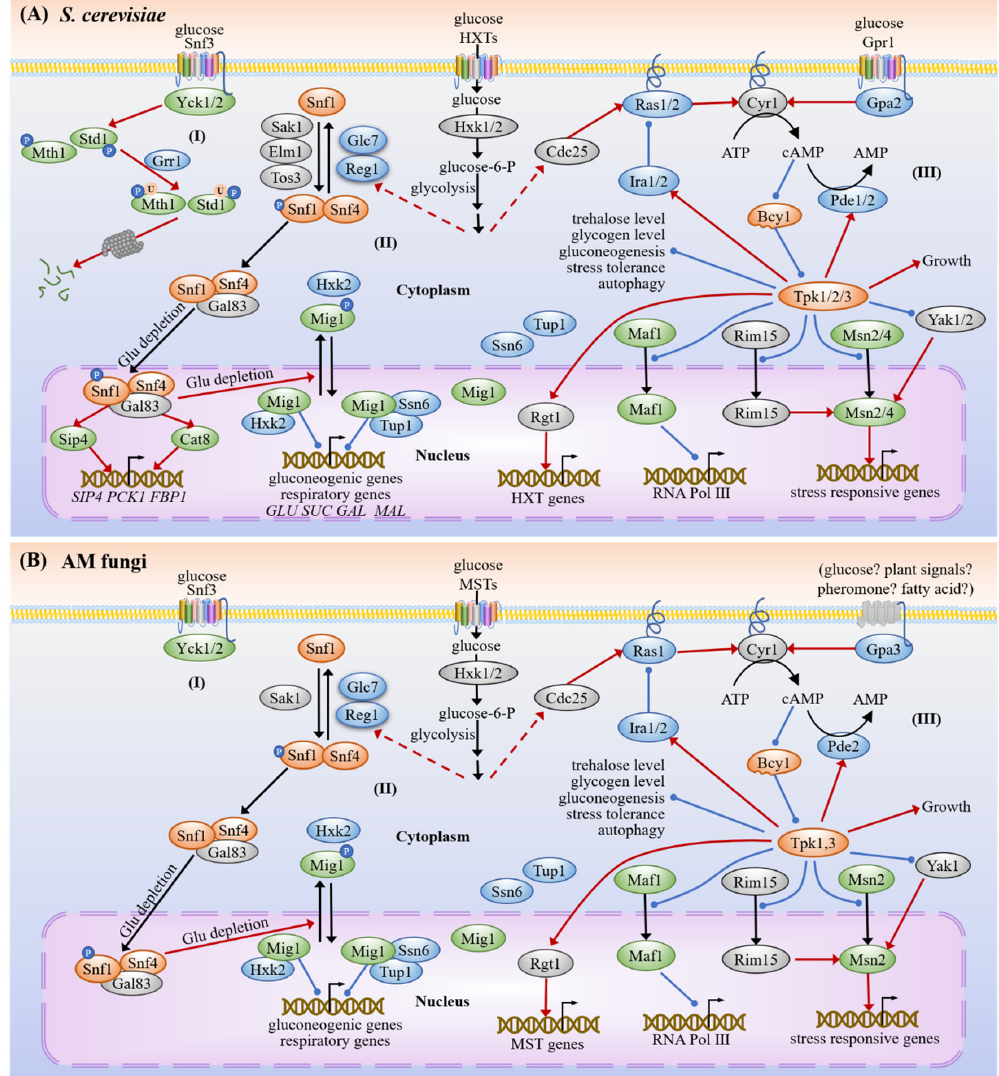
Figure 2. Carbon sensing and signaling pathways in yeast ( A ) and AM fungi ( B ). In the presence of glucose, Snf3/Rgt2 and Tpk3-dependent protein kinase trigger the induction of hexose transporter genes expression via Rgt1. The hexose transporters transport glucose into the fungal cell. Then, the Hxk1 and Hxk2 promote an increase in the intracellular glucose content. During glucose starvation, the activated Snf1 interacts with Snf4 and one of β -subunits Gal83/Sip1/Sip2 to form the SNF1 complex, which prevents the nuclear localization of both Hxk2 and Mig1. In the presence of glucose, Mig1 associates with its co-repressors Ssn6 and Tup1 to repress the expression of genes related to the availability of alternative carbon sources, such as sucrose, maltose and galactose, and regulates the transcription of the monosaccharide transporter genes ( MSTs ) in AM fungi. In the cAMP-PKA cascade, both Ras systems composed of Cdc25-Ras1-Ira1/2 sensing the intracellular glucose, and the G α subunit Gpa2/3 sensing extracellular glucose, can activate the Cyr1 to generate cAMP with ATP as the substrate. Then, cAMP binds to Bcy1 and releases the Tpks, causing the activation of PKA. PKA suppresses cAMP accumulation via Ira1/2 and Pde2. On the other hand, PKA can directly phosphorylate the trehalase that is responsible for the rapid changes in trehalose levels and prevent the entrance of Maf1, Rim15 and Msn2 to the nucleus; thus, it regulates the expression of genes involved in Pol III activity, stress-response, tolerance and cell life span. In AM fungi, the extracellular glucose, plant signals, pheromone and fatty acid may activate cAMP-PKA via G protein α subunits Gpa3. AM fungi have two PKA catalytic subunits, Tpk1 and Tpk3, while t he protein kinases Mth1, Std1, Grr1, Elm1 and Tos3 are not found in the genomes of AM fungi. The red lines with arrows indicate facilitation, whereas the blue lines with the dots indicate inhibition and the black arrows represent translocation or transformation.